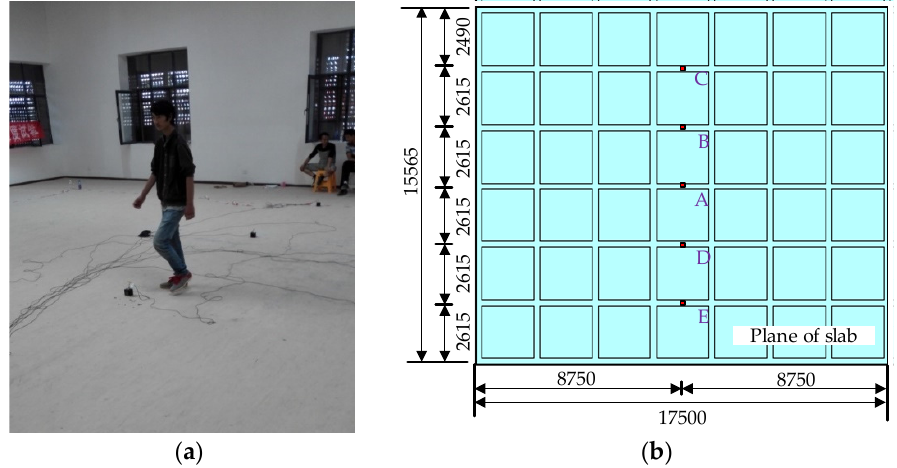
Figure 18. Dynamic response test: ( a ) test site; ( b ) layout position of acceleration sensors. According to the actual measurement size, the finite element model of the 15.6 m × 17.5 m span open-web sandwich plate was established at a ratio of 1:1. The translational and rotational degrees of freedom of the grid intersections around the floor were constrained. We set the point of excitation at the geometric center of the floor (point A) for the transient analysis, and peak acceleration responses at different locations on the floor are recorded. The nonlinear curve was fitted to the finite element calculation results according to Equation (6) to obtain the model curve. A comparison between the model curve and the peak acceleration response of the measured points (A~E) on the project site is shown in Figure 19. It can be seen in Figure 19 that the model curve was consistent with the measured data. Table 9 shows a comparison between the fitting results and the measurement results for each measuring point. The maximum measurement error was less than 6%, indicating that the method proposed in this paper could effectively calculate the acceleration distribution characteristics of the sandwich plate.